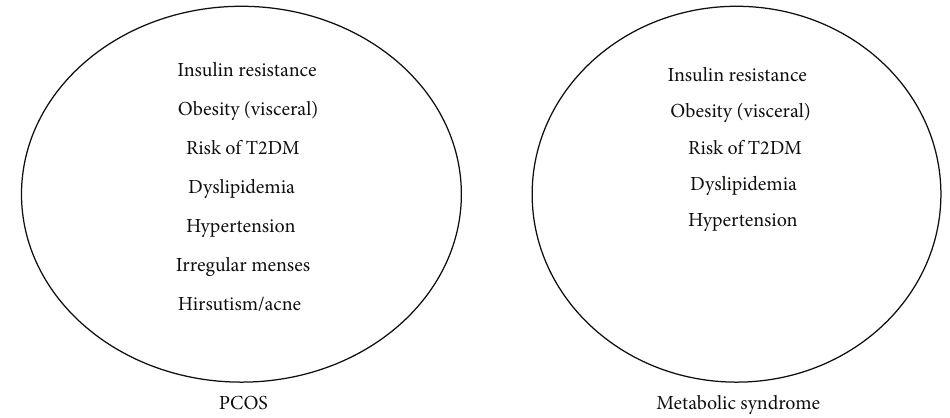
Figure 1: Common features of PCOS and the metabolic syndrome. Adapted from Tfayli and Arslanian [14].